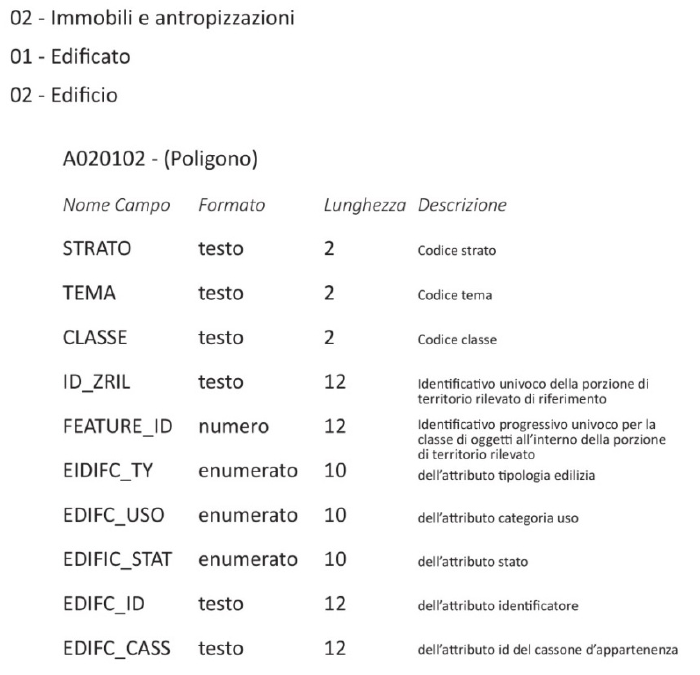
Figure 7. An excerpts from Annex A of DGR 6650. It shows the classification system and its use with a building.